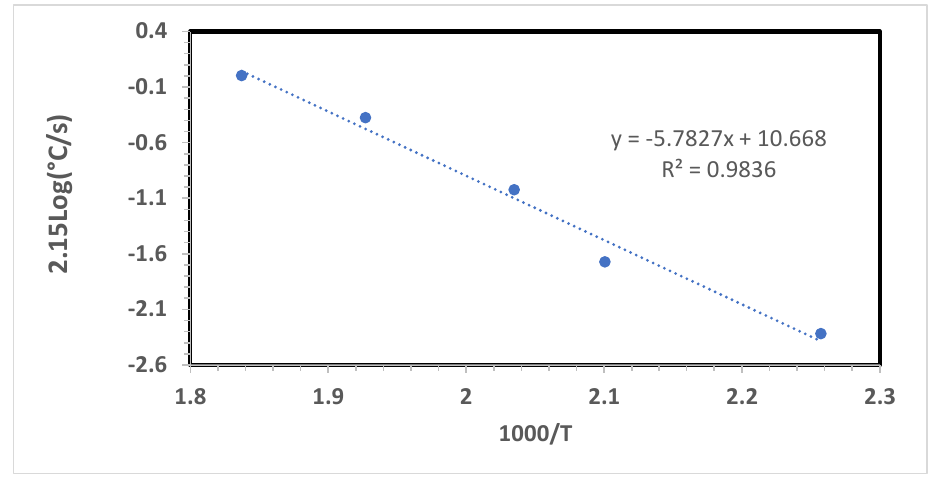
Figure 5. Determination of the activation energy for the vulcanization on compound B, Table 1 according to the Ozawa equation. The activation energy is represented by the slope which, multiplied by the gas constant R it gives an E # = 48.0 kJ/mol. The Kissinger method gives a comparable activation energy of E # = 47.0 kJ/mol.